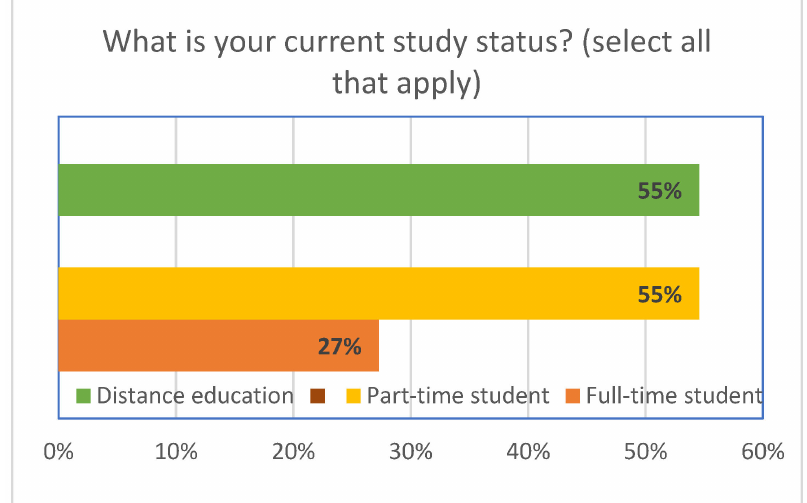
Figure 5. Study status of respondents. Even though the unit is taken as a core and optional unit across disciplines, the re‑ spondents mainly stemmed from accounting and financial planning majors (Figure 6).